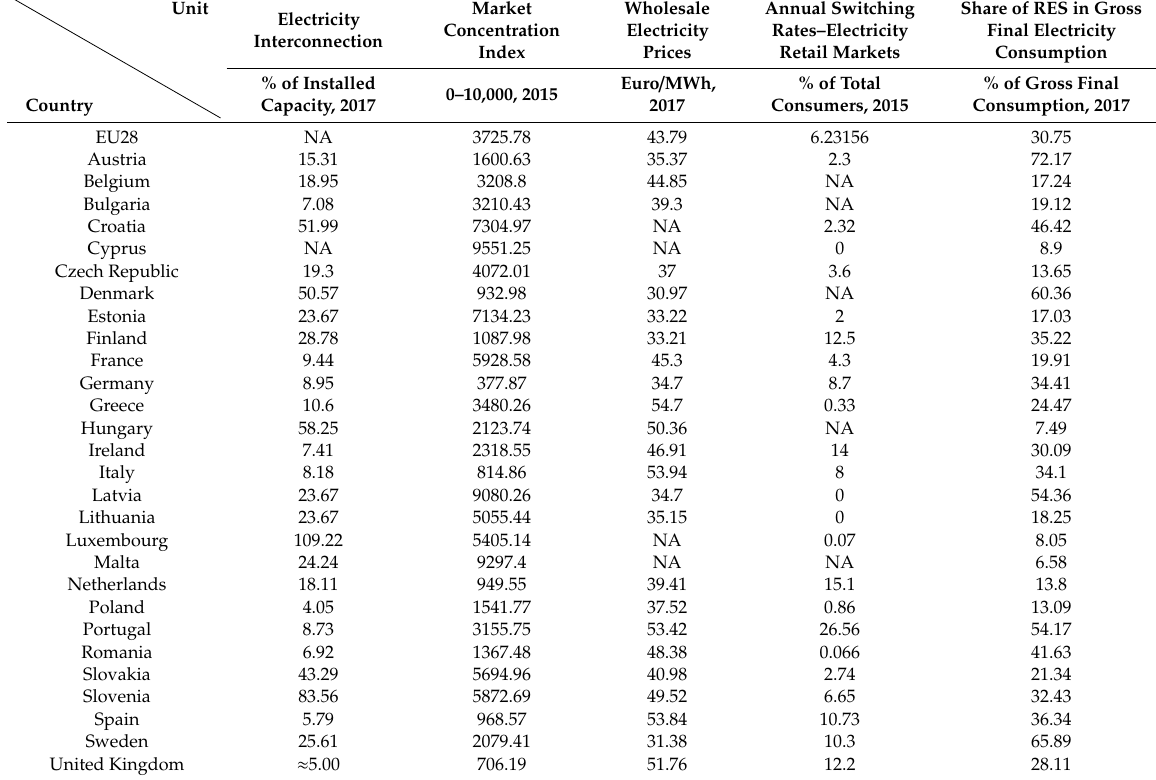
Table 3. Indicators for monitoring the progress of the electricity sector toward Energy Union objectives.